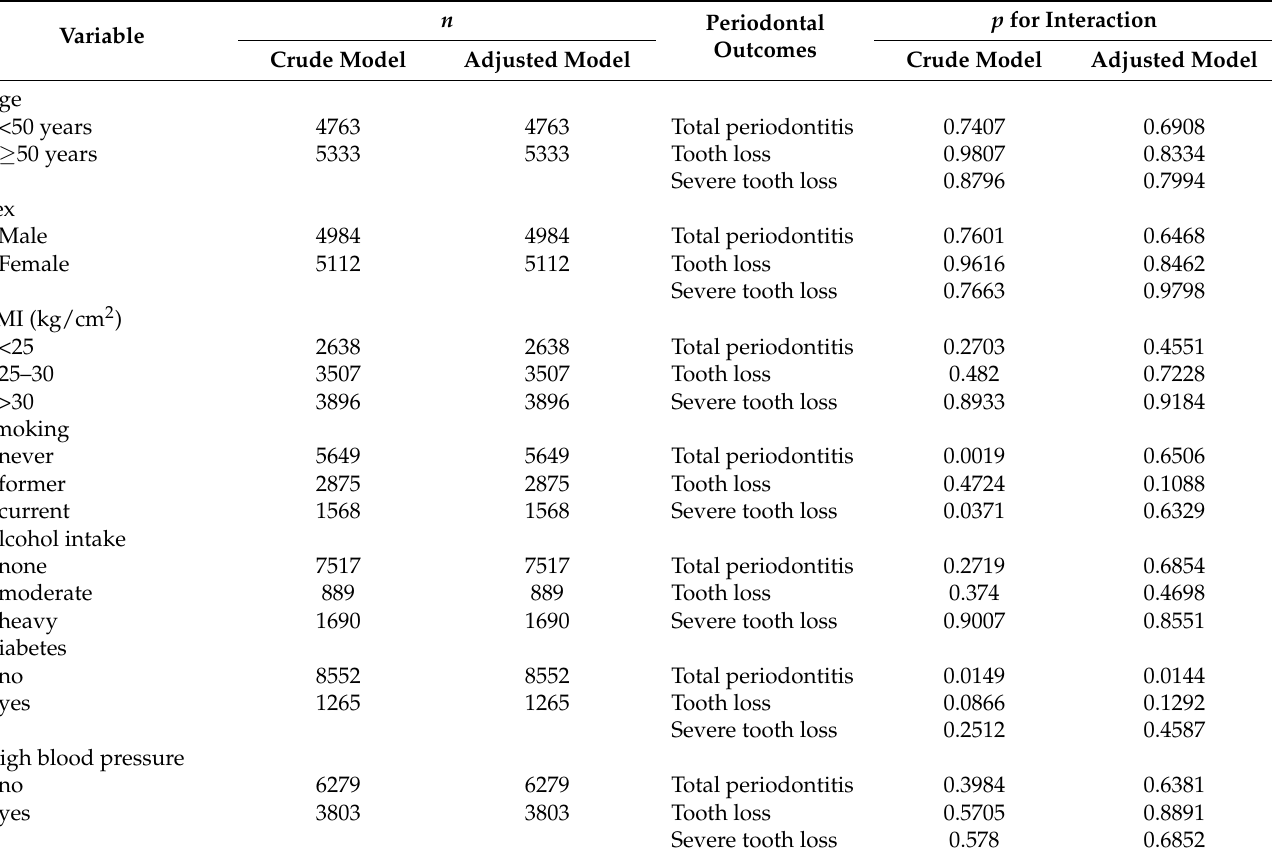
Table 3. Stratified logistic regression analysis to identify variables that have interaction effects between DII and risk of periodontal